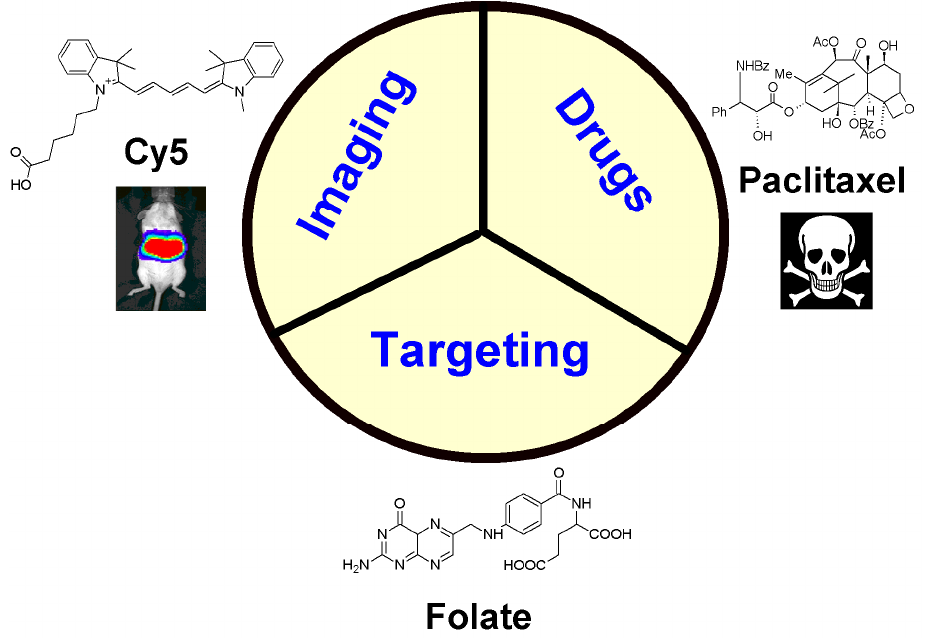
Figure 1. The three main classes of functionalities that comprise a multifunctional nanoparticle for cancer diagnostics and therapy. A tumor-specific targeting moiety, such as the folate molecule, recognizes the folate receptor on the tumor cell surface to provide directed delivery of an imaging probe, for example the Cy5 fluorescent molecule, and/or the treatment agent, for example the chemotherapy drug